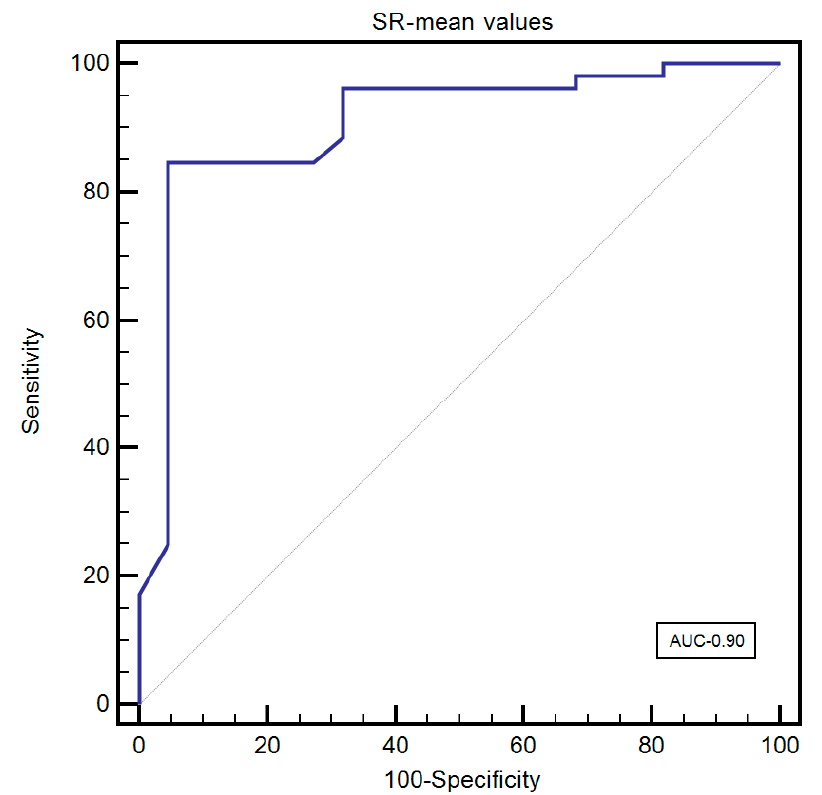
Figure 4. The area under the receiver operating characteristic curve (ROC-curve) for SR measurements.